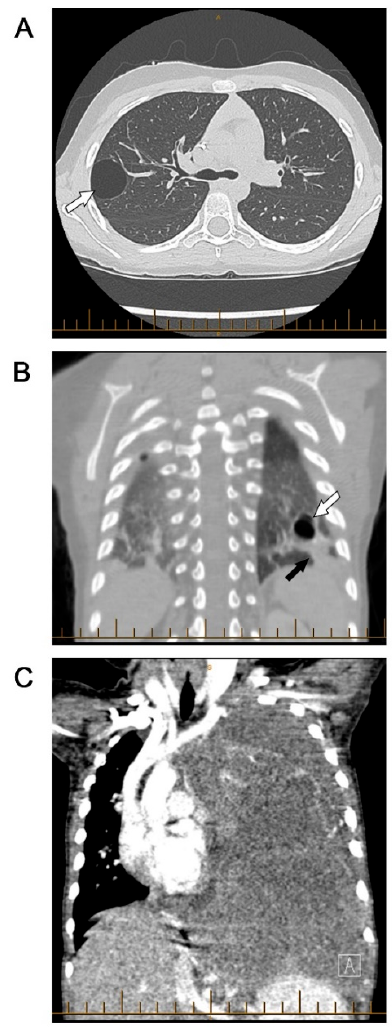
Figure 1. Types of pleuropulmonary blastomas (PPB) ( A ) Type I purely cystic PPB (white arrow). ( B ) Type II PPB with cystic (white arrow) and solid (black arrow) components. ( C ) Type III purely solid PPB occupying the entire left hemithorax.